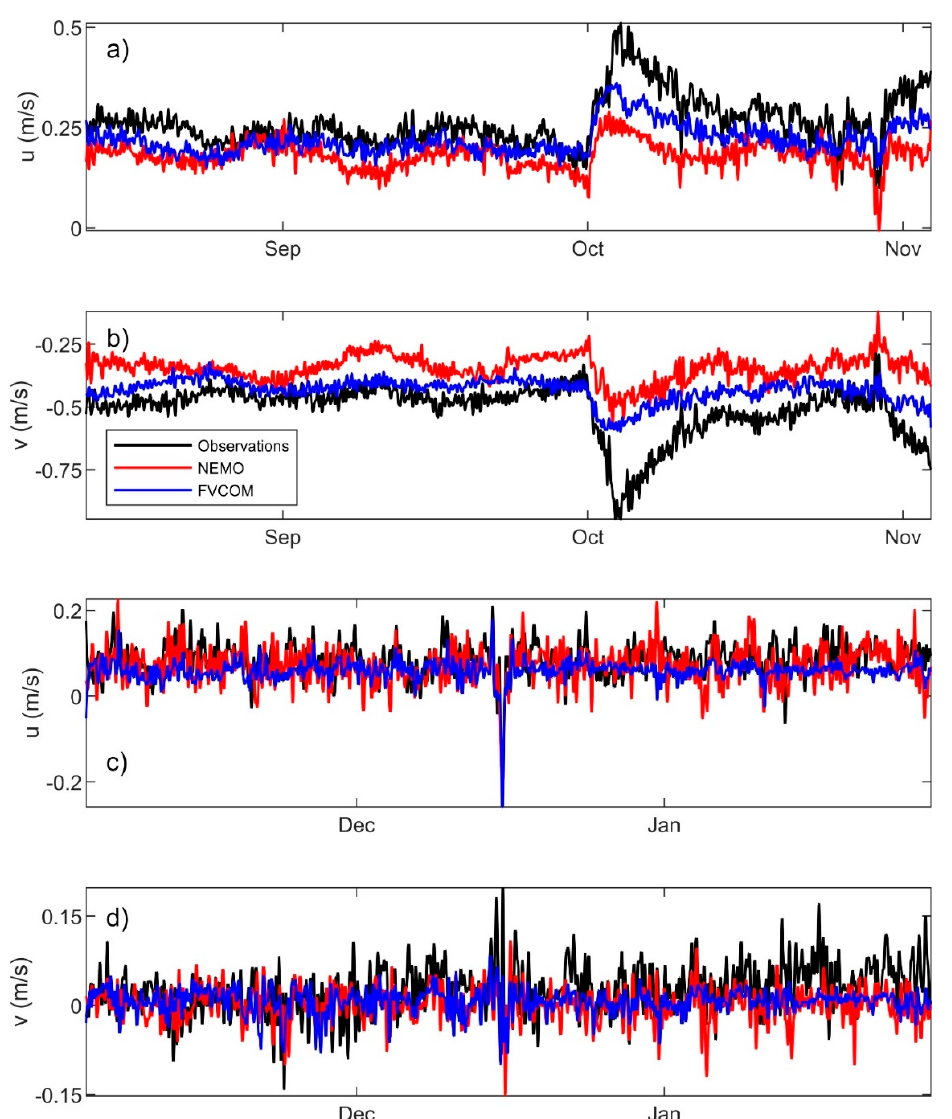
Figure 5. Observed (black) and modelled (NEMO, red; FVCOM, blue) time series of the u and v components of the residual currents, at the representative stations in the inner harbour ( a , b ) and outer harbour ( c , d ). The residual currents were computed by removing the tidal component (as determined by t_tide). An additional filter was applied to remove the extra energy in the tidal period bands (22–28 h, 11–14 h) and all energy at periods < 7 h.